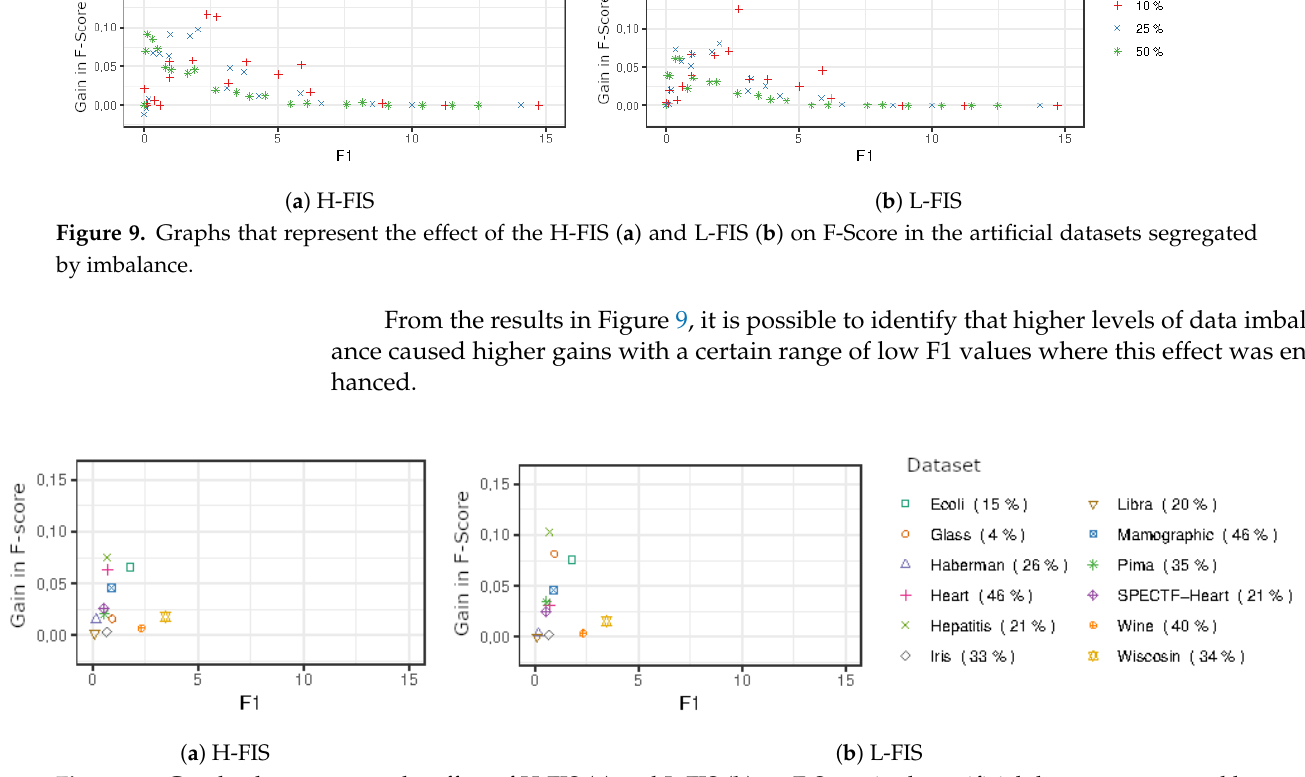
Figure 10. Graphs that represent the effect of H-FIS ( a ) and L-FIS ( b ) on F-Score in the artificial datasets segregated by imbalance. The positive class ratio of that dataset is mentioned in parentheses.